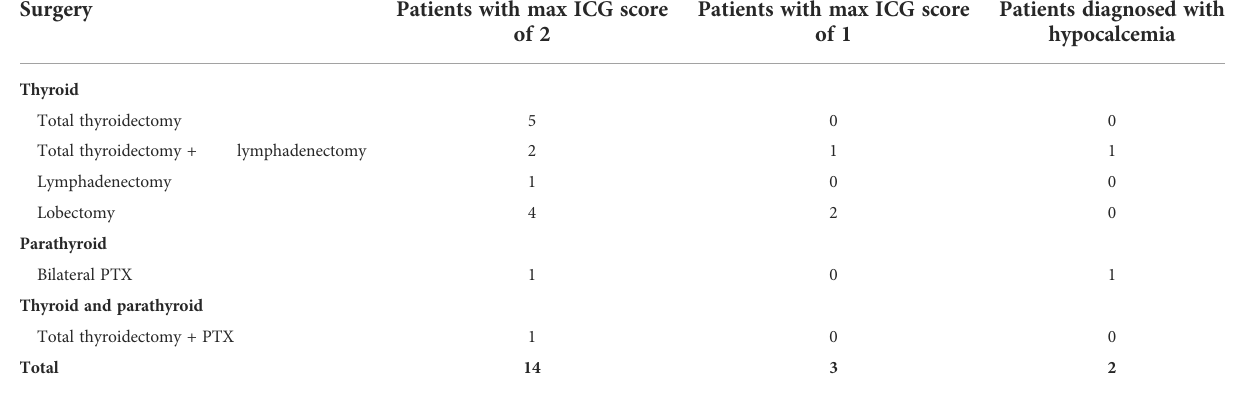
TABLE 2 ICG score and postoperative hypocalcemia status of 17 patients whose PTGs were evaluated by ICG angiography using EleVision IR after thyroid and parathyroid